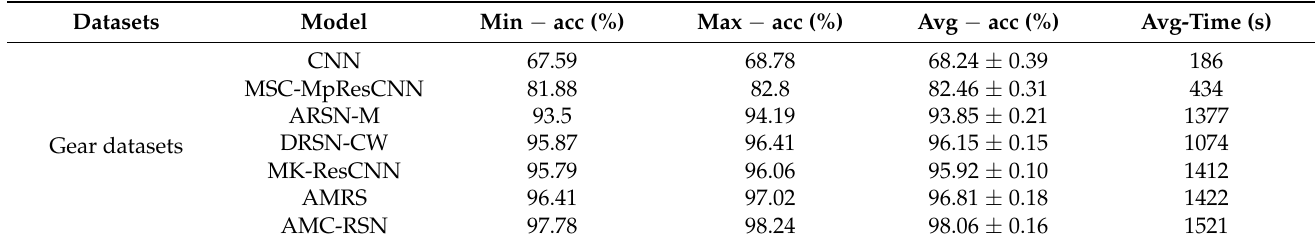
Figure 9. Diagnostic results of different models for the gear datasets. Table 4. Fault diagnosis results in gear.